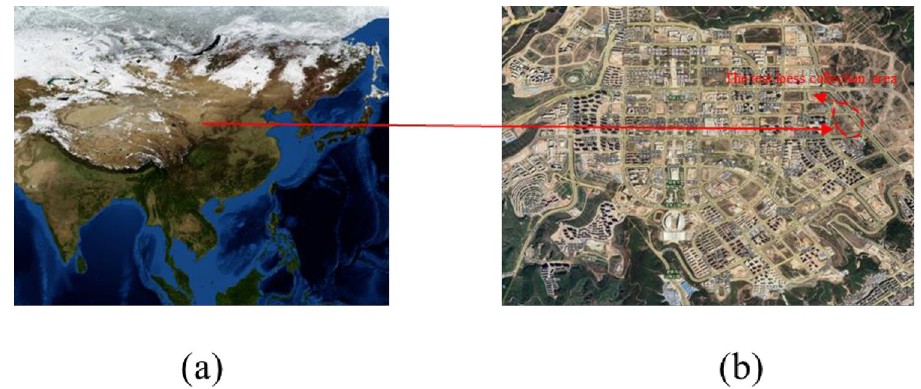
Fig 1. The loess sample collection area. ((a) and (b) are publicly available and free, the source is http://https://eol.jsc. nasa.gov/).